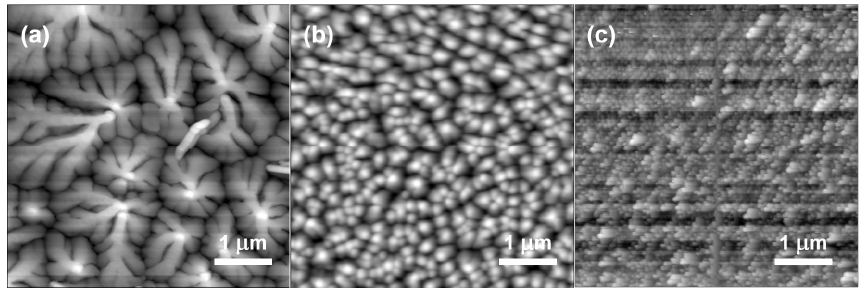
Figure 5. Atomic force microscopy (AFM) topography images of the pentacene films on pure PMMA dielectric ( a ); ZnO/PMMA hybrid dielectrics ( b ) and CuPc film on it ( c ).